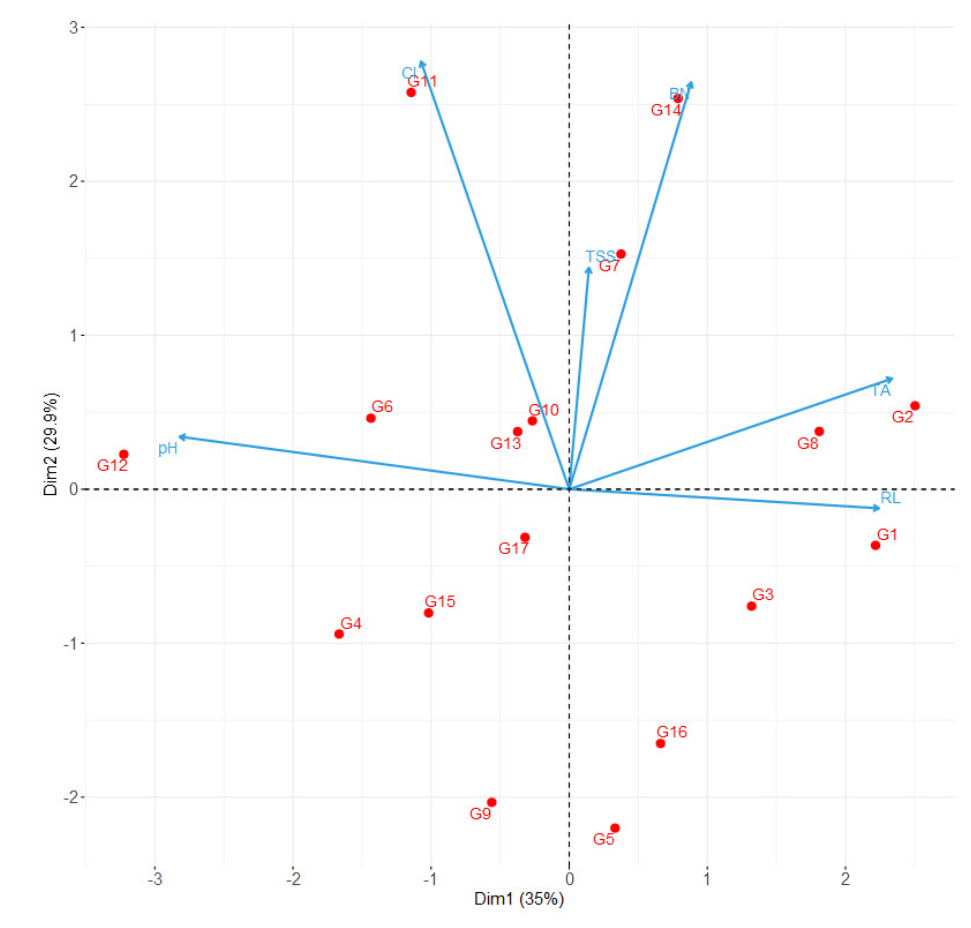
Figure 1. Bi-plot of the 17 ‘Greco’ clones (from G1 to G17) for the first principal components extracted by the PCA. The vectors indicate the original variable loadings. BN—number of berries per bunch; RL—Rachis length; CI—bunch compactness index; TSS—berry juice total soluble solids; pH—berry juice pH; TA—berry juice titratable acidity.